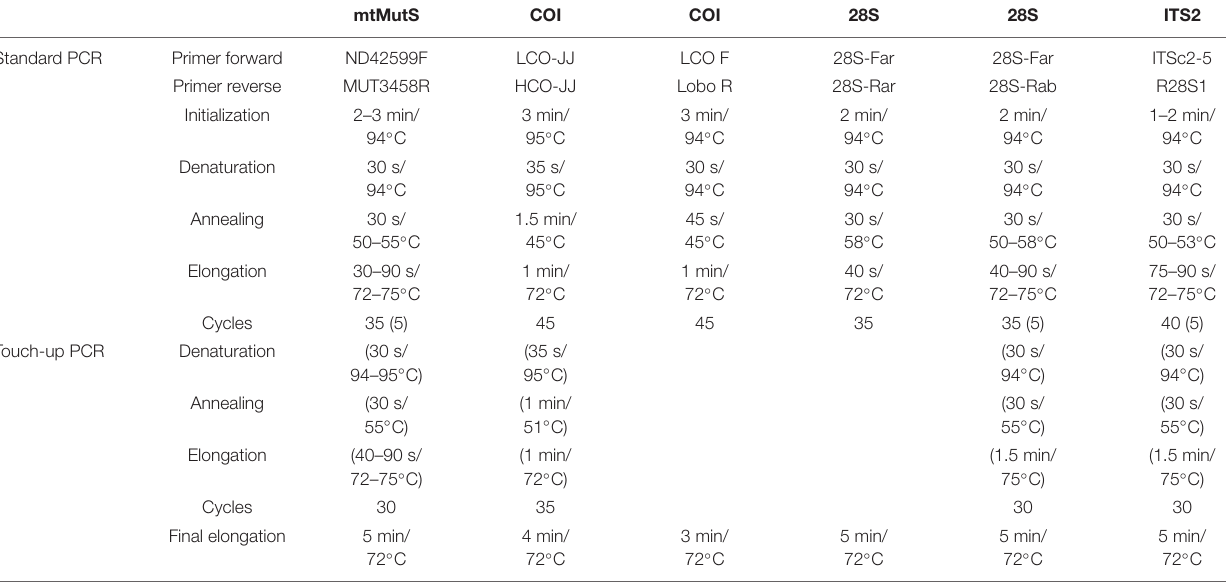
TABLE 1 | PCR protocols used in this study.